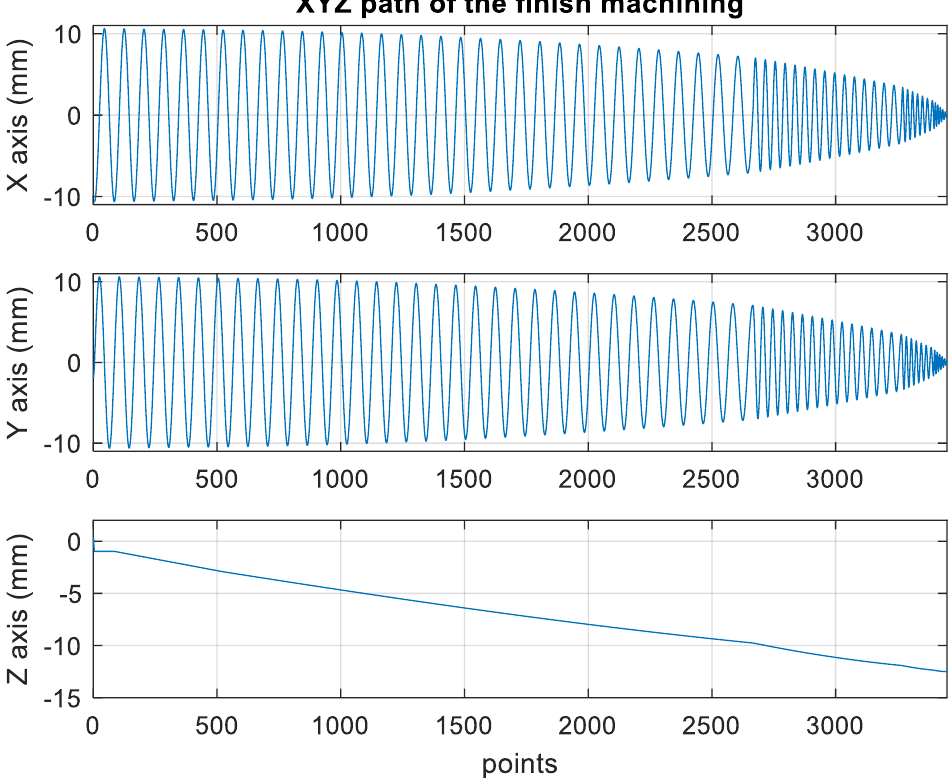
Figure 14. XYZ path of original finish machining program.